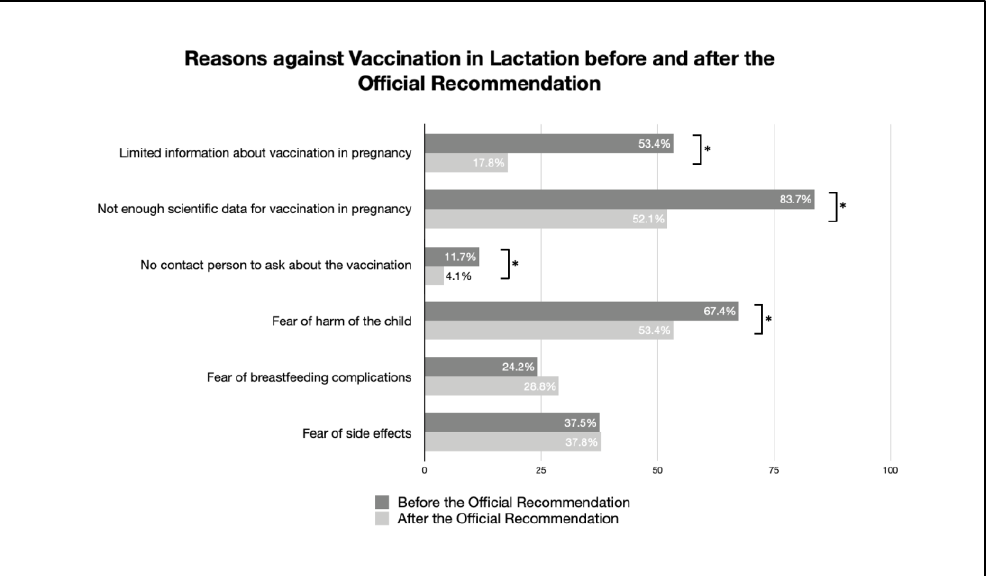
Figure 6. Reasons against vaccination in lactation before and after the official recommendation (per- centage of reasons given by participants against being vaccinated; multiple answers possible; * in- dicates a significant difference).